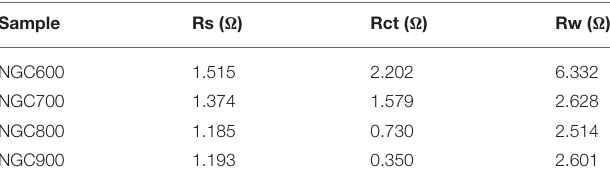
TABLE 2 | Kinetic parameters of NGC600, NGC 700, NGC 800, and NGC 900 electrodes.